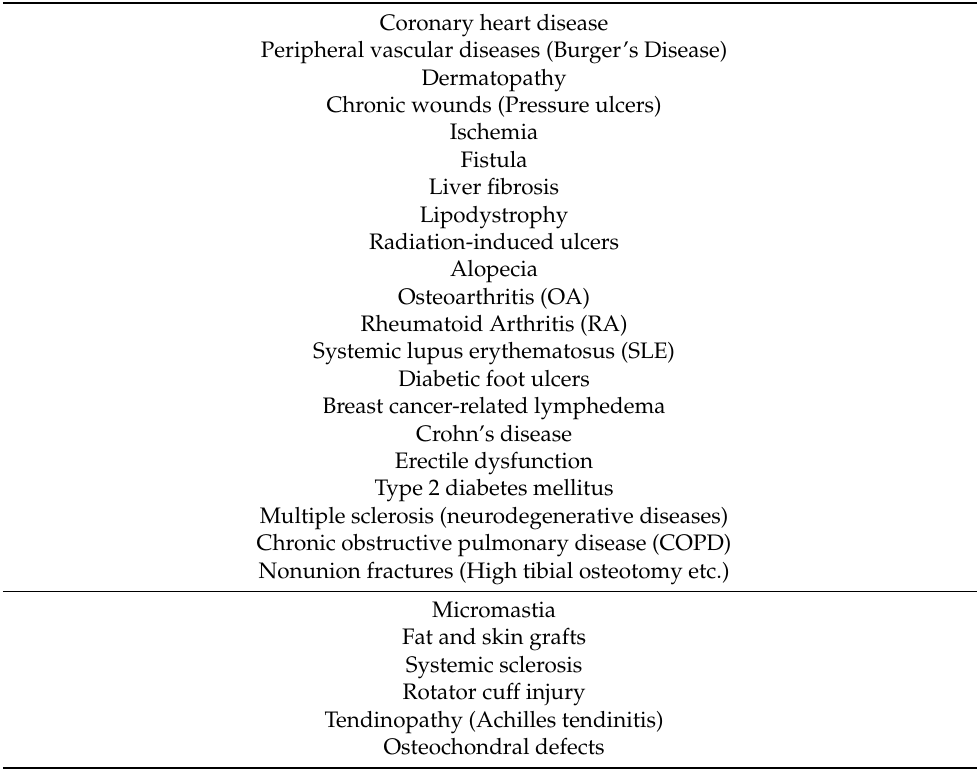
Table 1. Diseases in which Stromal Vascular Fraction Obtained from Adipose Tissue can be